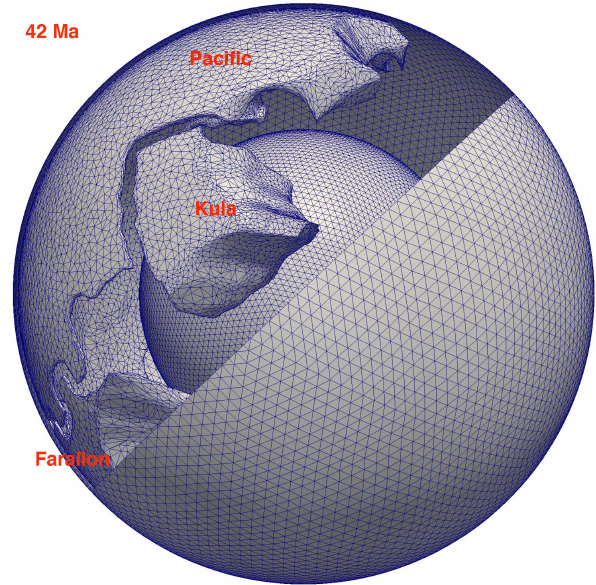
Figure 1. The initial starting model used for input into BEM-Earth. Each isosurface bounds a region of discrete viscosity and density as described in Table 1. The external Earth surface has been peeled back to show the other core and plate isosurfaces, with the view centred near the North Pole. The modelled plates, here at 42Ma, are the Kula, Farallon and Pacific. The blue mesh is indicative of model resolution and shows the panels that are free to deform.